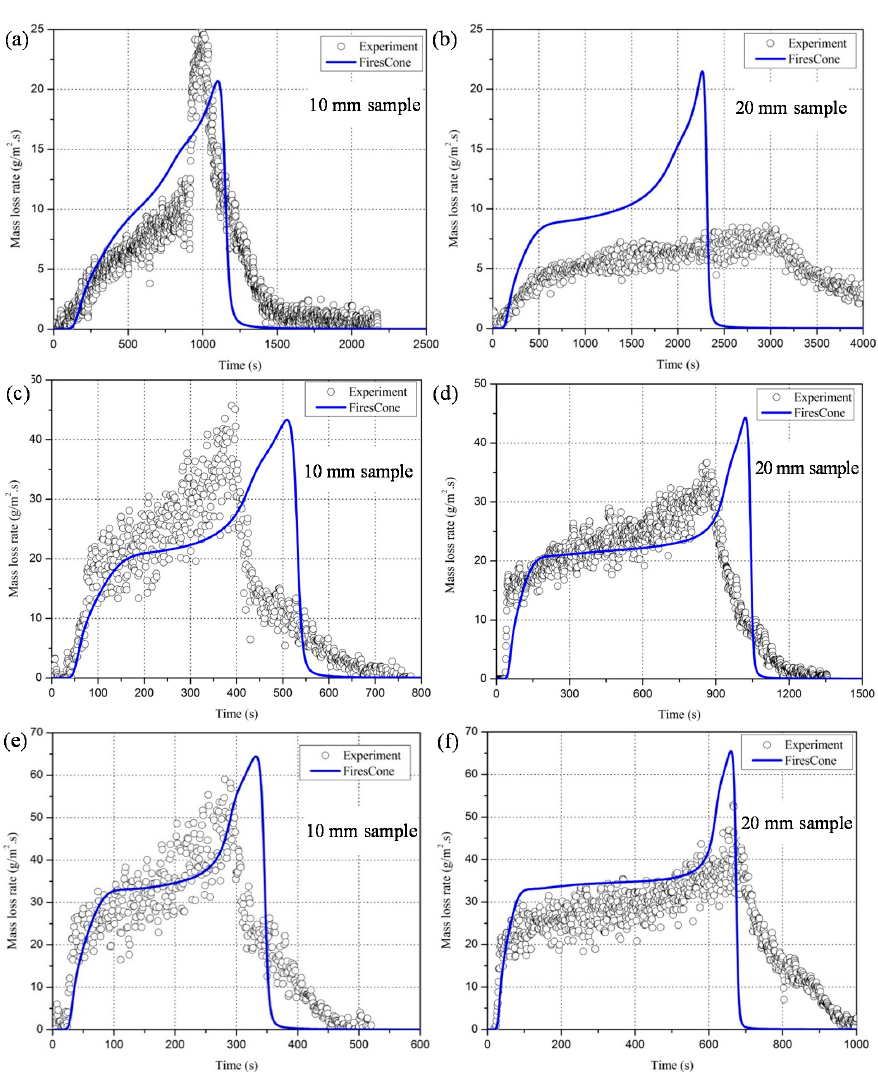
Figure 2. Comparisons between modeling and experimental results for PMMA under different heat fluxes: ( a , b ) 25 kW/m 2 ; ( c , d ) 50 kW/m 2 ; and ( e , f ) 75 kW/m 2 . fluxes: ( a , b ) 25 kW/m 2 ; ( c , d ) 50 kW/m 2 ; and ( e , f ) 75 kW/m 2